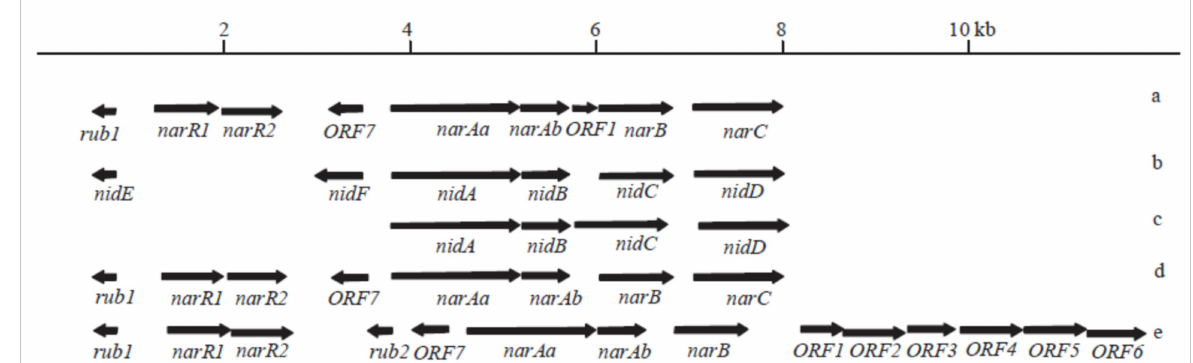
Figure 2. Organization of the naphthalene degradation gene clusters in (a) Rhodococcus ruber OA1 (GenBank acces- sion number KY072804), (b) Rhodococcus opacus TKN14 (GenBank accession number AB206671.1), (c) Rhodococcus sp. I24 (GenBank accession number AF121905.1), (d) Gordonia sp. CC-NAPH129-6 (GenBank accession number GQ848233.3), and (e) Rhodococcus sp. NCIMB12038 (GenBank accession number AF082663.3) [Reproduced with permission from Sun et al. [87], as an open access article distributed under the terms of the creative commons attribution License, which permits unrestricted use, distribution and reproduction in any medium, provided the original author and source are credited, https://docsdrive.com/pdfs/ansinet/biotech/2017/165-173.pdf, accessed on 11 September